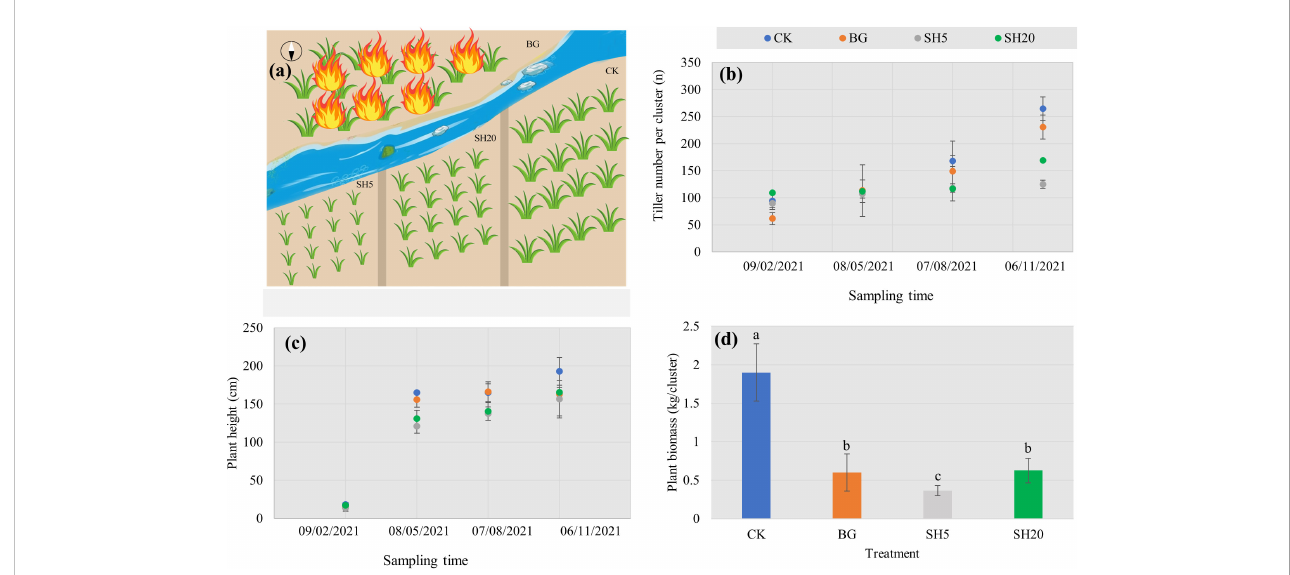
FIGURE 1 Concept map of experimental design with four treatments of control (CK), slightly (SH5) and deeply mowed (SH20), and burned grass plot (BG) (A) , and their effects on traits of Miscanthus with the growth period: Tiller number per cluster (B) , Plant height with different treatments (C) , and Miscanthus biomass (dry weight per cluster) after harvest (D) . Within each subgraph according to Tukey ’ s mean separation test, values with the same lower case presents a non-signi fi cant difference ( p =0.05), while different lower-case letters show a signi fi cant ( p <0.05)